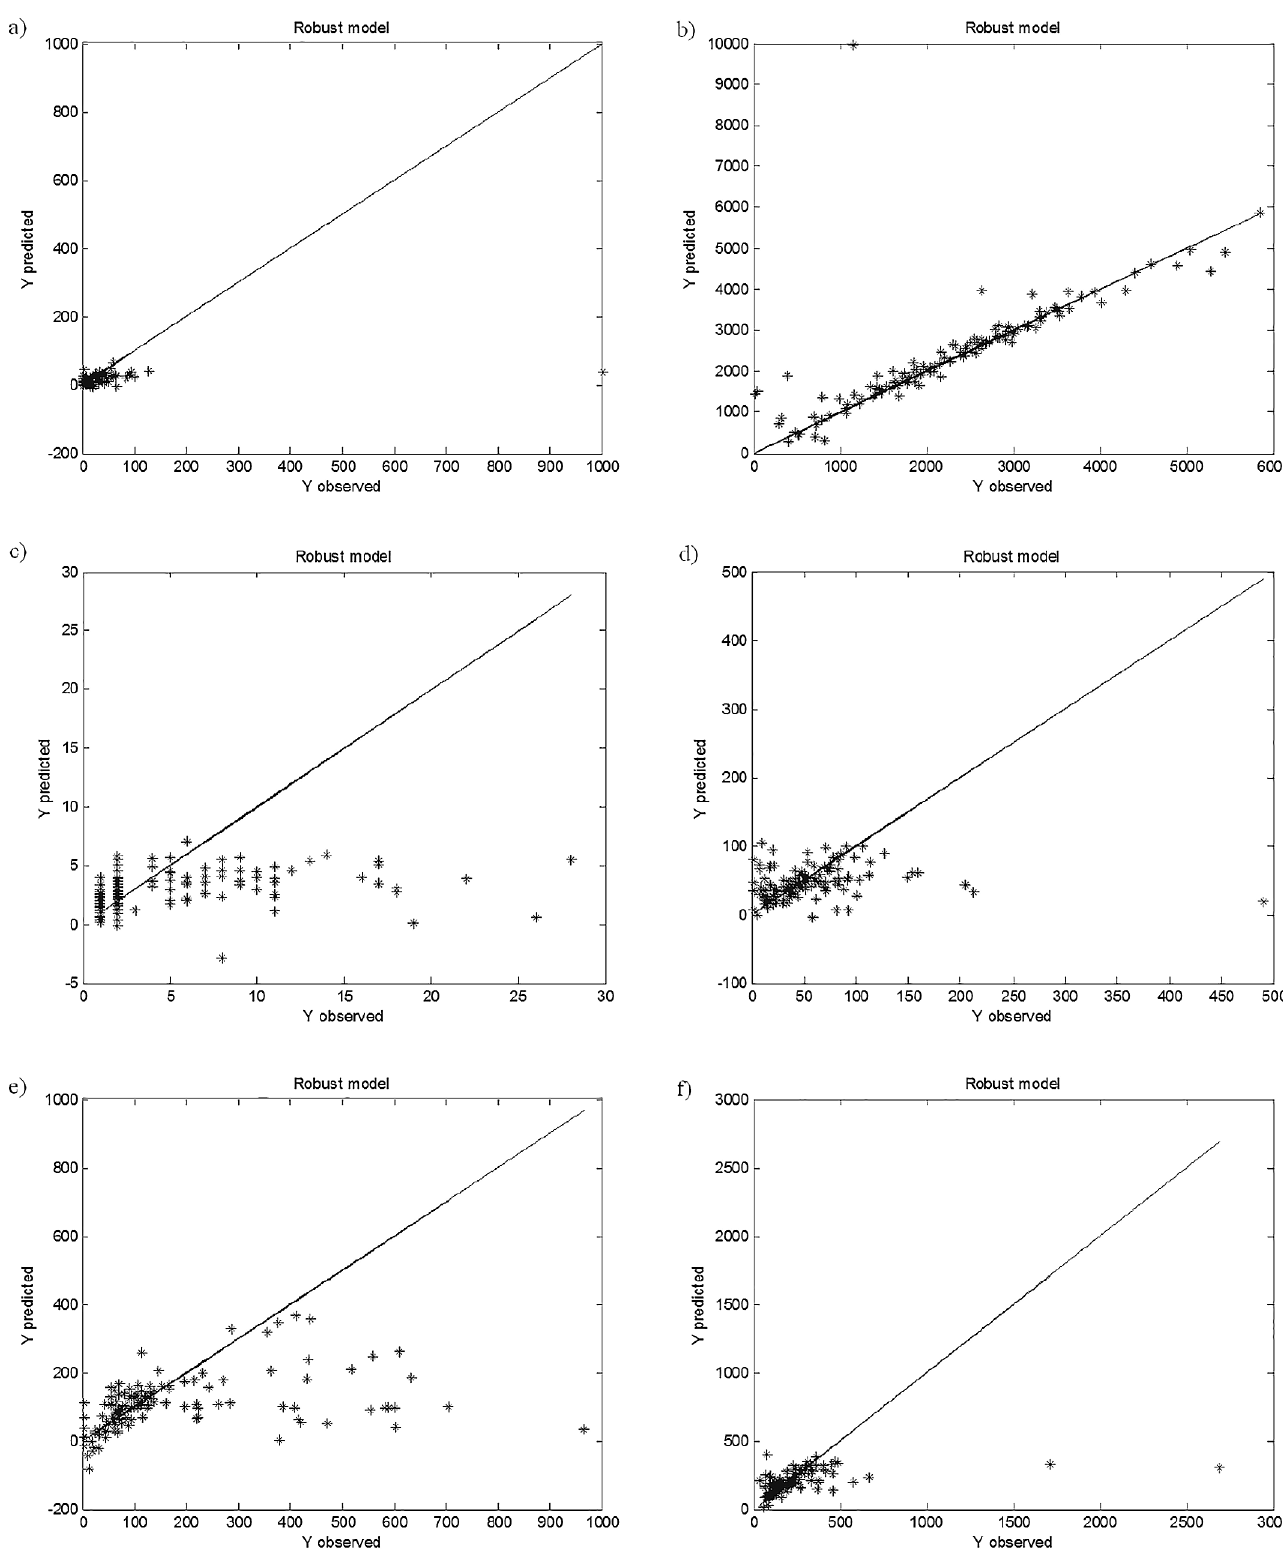
Fig 3. rPLS models of trace elements concentrations: (a) As, (b) Ba, (c) Cd, (d) Co, (e) Cr, (f) Cu, (g) Mn, (h) Ni, (i) Pb, (j) Rb, (k) Sr, (l) V and (m) Zn in μ g/g, based on the parameters specified in Table 1, with the assumed fraction of outliers of 30%. doi:10.1371/journal.pone.0159265.g003 PLOS ONE | DOI:10.1371/journal.pone.0159265 July 20,